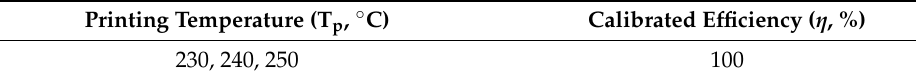
Table 4. Calibrated efficiency for heat flux model.